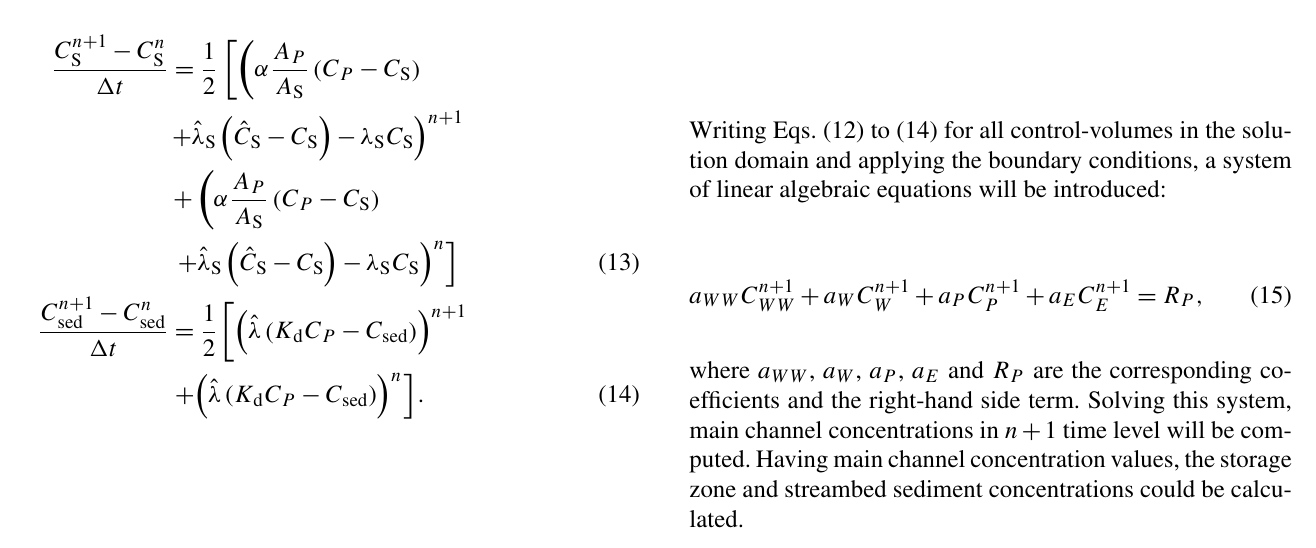
where a WW , a W , a P , a E and R P are the corresponding co- efficients and the right-hand side term. Solving this system, main channel concentrations in n + 1 time level will be com- puted. Having main channel concentration values, the storage zone and streambed sediment concentrations could be calcu-